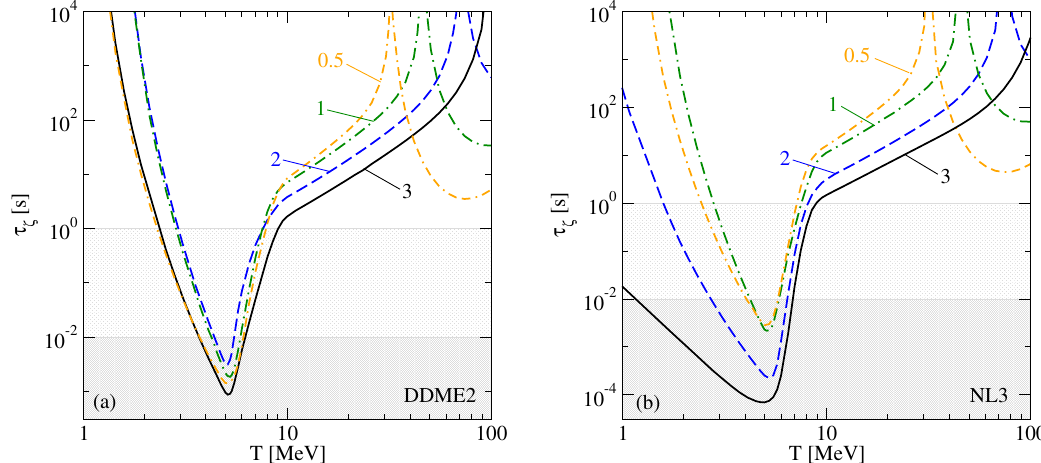
Figure 9. The oscillation damping timescale as a function of temperature for various densities, interpolating between the neutrino-transparent and neutrino-trapped regimes as in Figure 8 but for f = 10 kHz; ( a ) model DDME2; ( b ) model